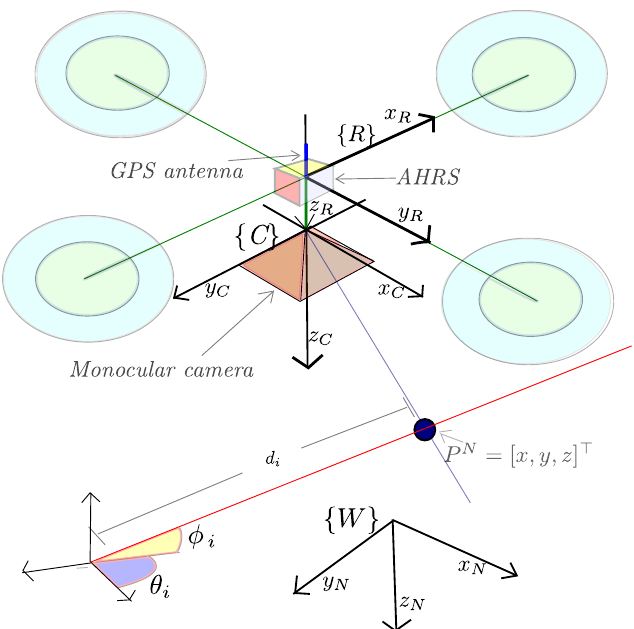
Figure 1. Coordinate systems: the local tangent frame is used as the navigation reference frame N . AHRS: Attitude and Heading Reference